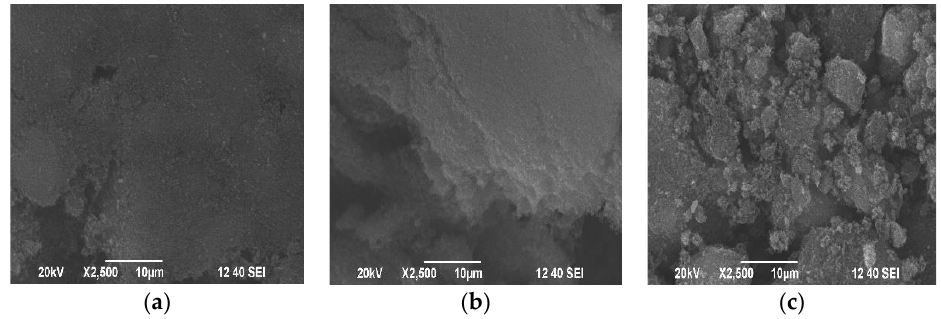
Figure 2. The SEM images of the carbon black samples: ( a ) CB-NM, ( b ) CB-Ox, and ( c ) CB-APTES. The EDS analysis results of the carbon black samples are shown in Table 3. The oxidation of the original carbon black surface increases oxygen content by about 1.7 times. In the case of carbon black modified by APTES deposition, the oxygen content is slightly less than that for CB-NM. The Si (larger amount) and N observed in this sample are derived from APTES